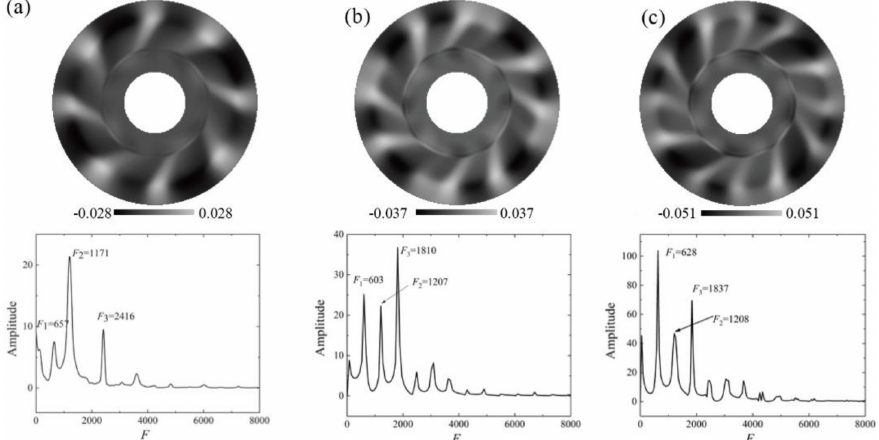
Figure 13. Transitions of surface concentration patterns ( top ) and the corresponding Fourier spectra analysis ( bottom ) at Re c = 936, ( a ) Re T = 9938, ( b ) Re T = 12,726, and ( c ) Re T =